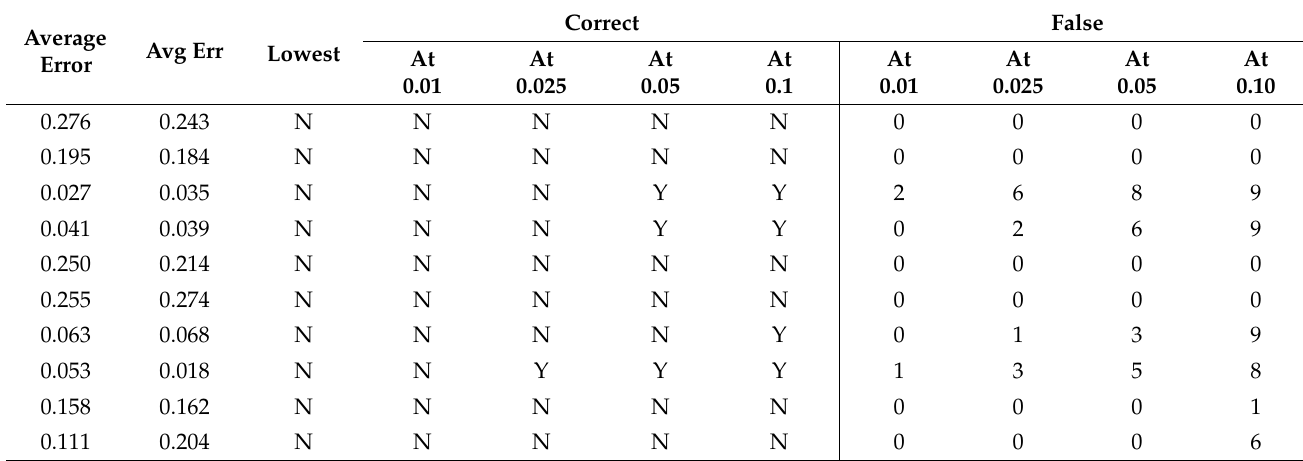
Table A31. Set 1, trials 11–20 summary data (average actual PR